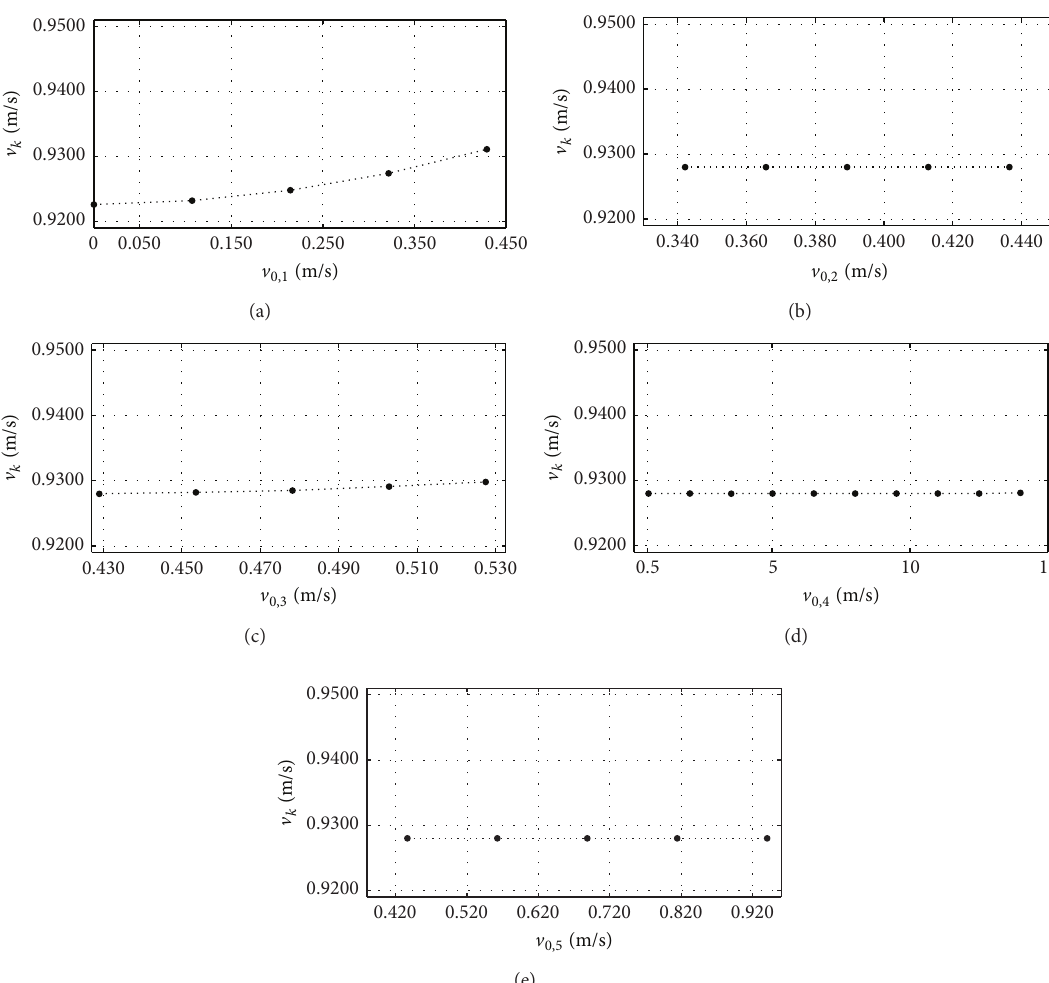
Figure 5: Characteristics of flow velocity at Katulampa with respect to the second variation of initial flow speed (a) F, (b) G, (c) H, (d) I, and (e) J.